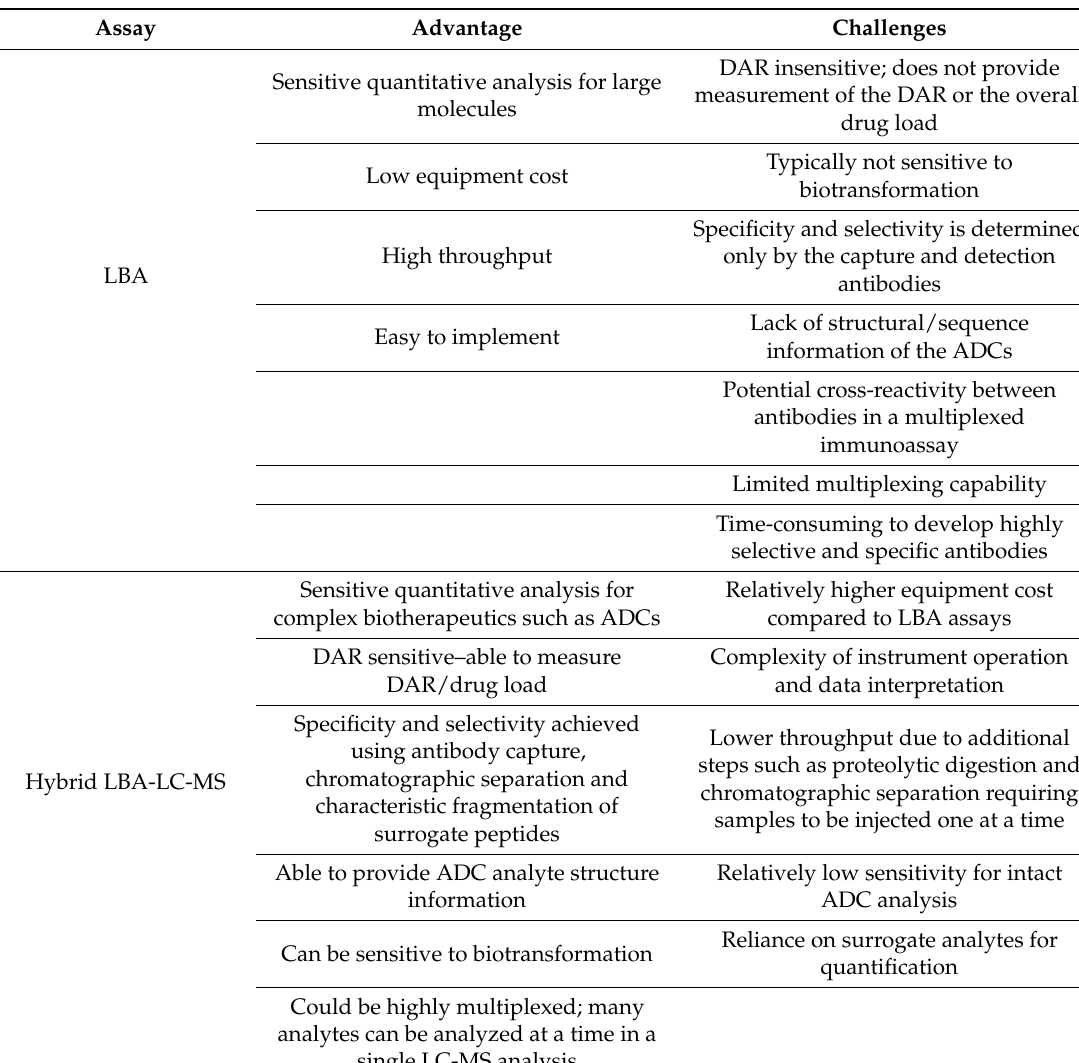
Table 1. The advantages and challenges of the ELISA-based immunoassay platform and hybrid ligand binding LC-MS (liquid chromatography-mass spectrometry)